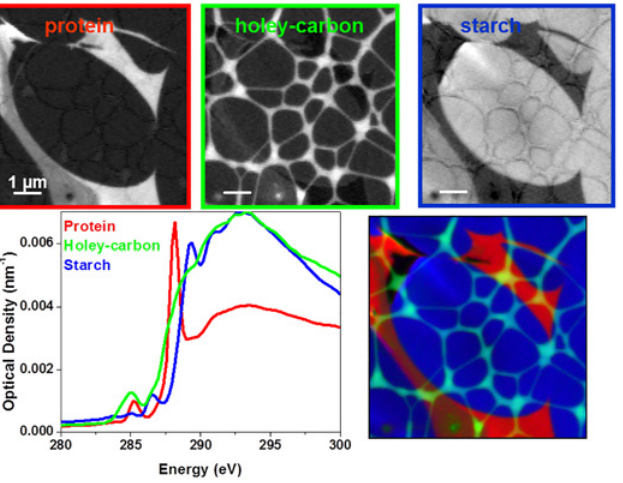
Fig 7. Compositional maps of starchy endosperm. Top row: component maps of protein, holey-carbon, and starch granules; bottom row: C 1s X-ray absorption spectra extracted from the components and the composite image showing all components in a single